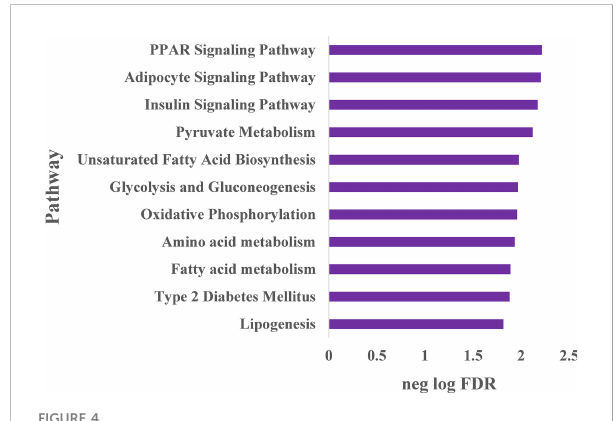
FIGURE 4 Whole transcriptome sequencing analysis of pathways stimulated by naringenin and b -carotene (NRBC) Adipocytes from two donors with BMI of 27 and 36 kg/m 2 were treated with cell medium (vehicle control) or NRBC for seven days. cDNA libraries from expressed transcripts were constructed, sequenced and differential gene expression was analyzed.